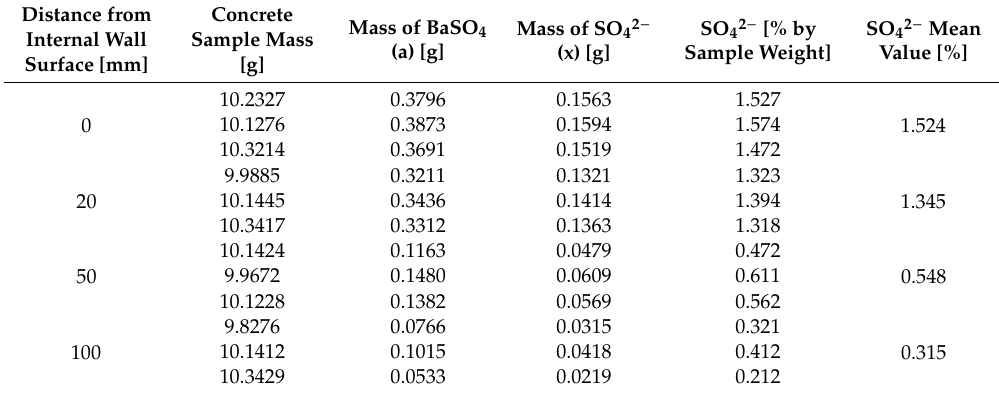
Table 1. Resultsofthegravimetricquantificationofsulphatesacrossthethicknessoftestedconcreteelements. Distance from Internal